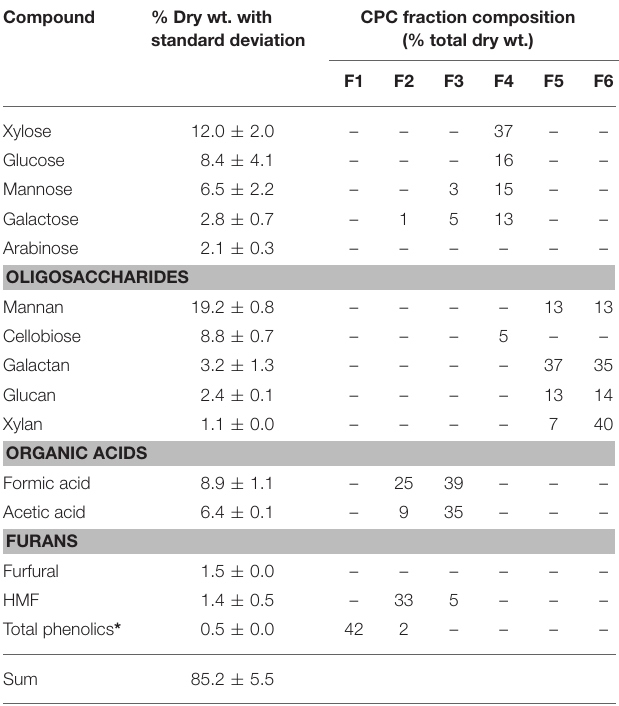
TABLE 4 | Composition of lyophilized pinewood liquid HW pre-hydrolyzate.